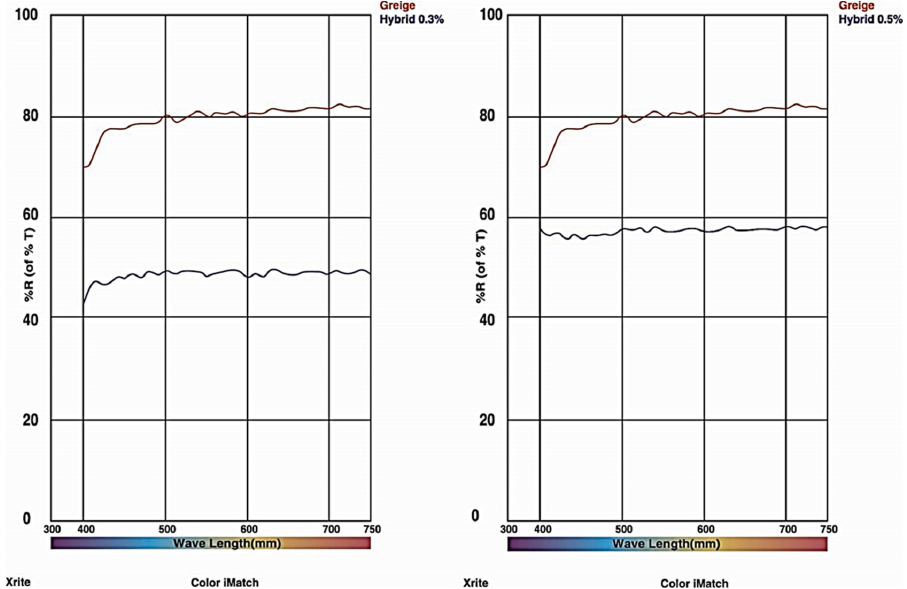
Figure 9. Image of the nano wavelength distribution of (Graphene+CNC) hybrid nanofluids.